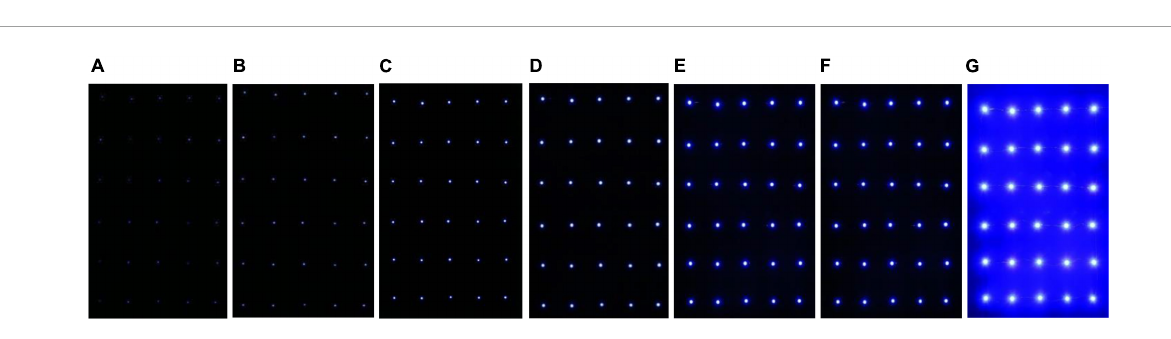
FIGURE5 LED-light sources with different light intensities. (A) 0.001 lux, (B) 0.01 lux, (C) 0.1 lux, (D) 10 lux, (E) 100 lux, (F) 1000 lux, (G) 2000 lux.